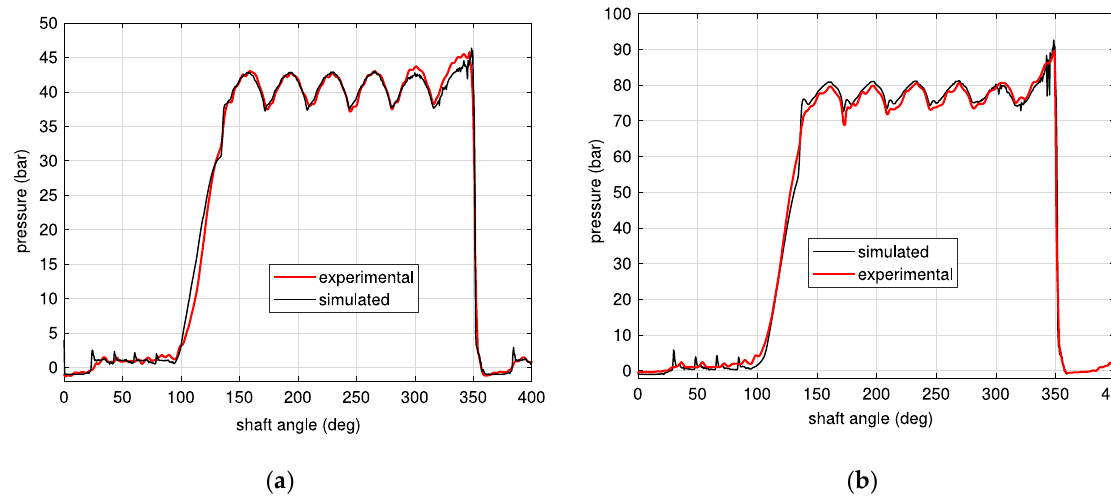
Figure 9. Chamber pressure with plates A at 750 rpm ( a ) and at 1250 rpm ( b ).